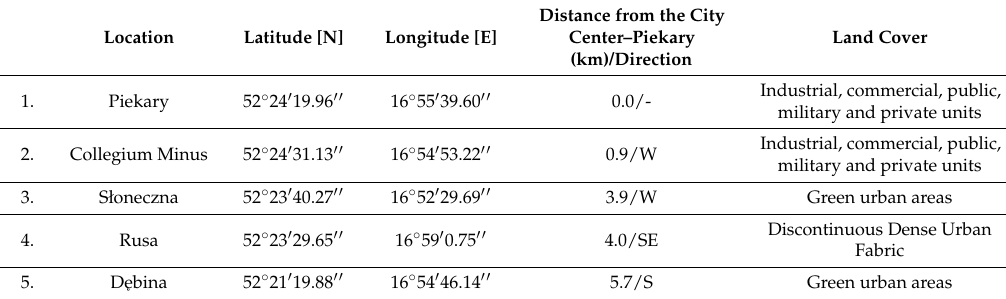
Table 1. Location and characteristics of measuring points in